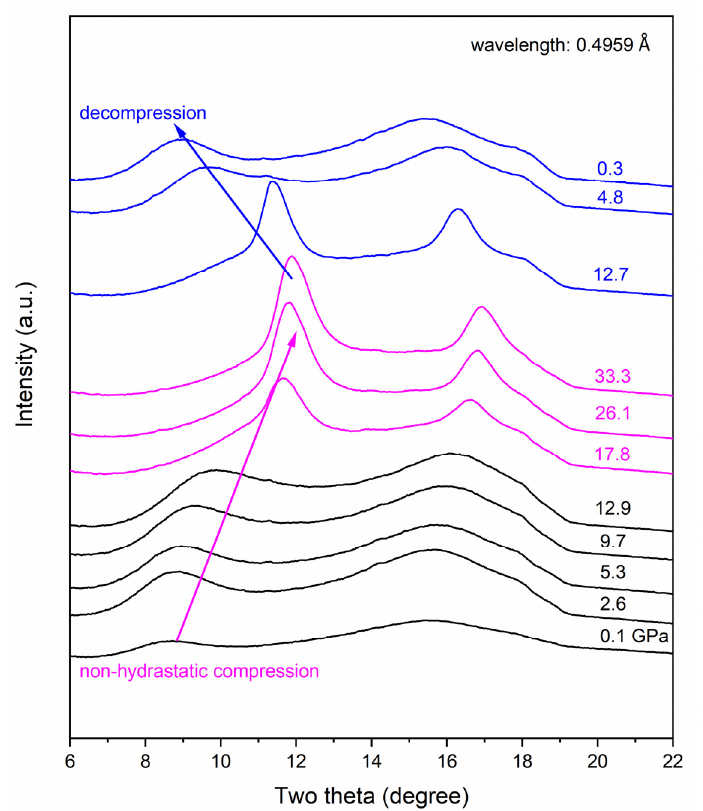
Figure 5. XRD characterization of amorphous Ge under non-hydrostatic pressures with a synchrotron X-ray wavelength of 0.4959 Å. No PTM was used to maintain non-hydrostatic pressure environment. The pressures are labeled above each diffraction line (unit: GPa). The peaks from the ruby ball have been masked. Note that this sample is fully amorphous.